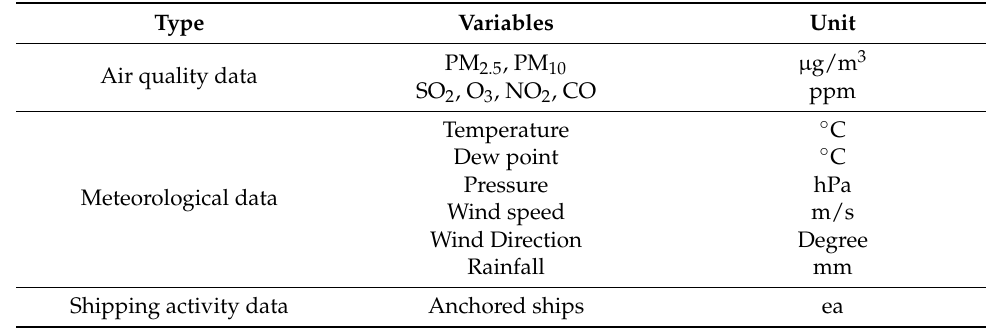
Table 1. Data types, variables, and units of input dataset of RNN-LSTM.